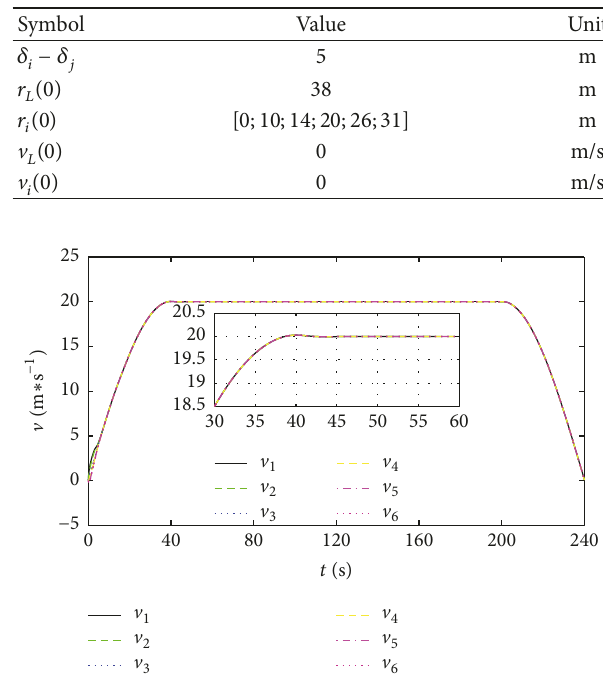
Table 1: Initial conditions and safe distance.